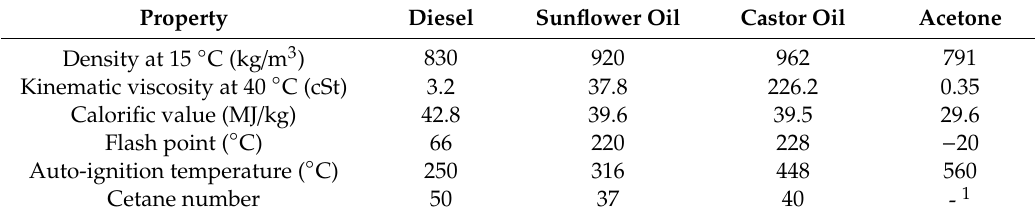
Table 4. Properties of diesel, sunflower oil, castor oil, and acetone [38–40]. Kinematic viscosity values were experimentally determined in the present